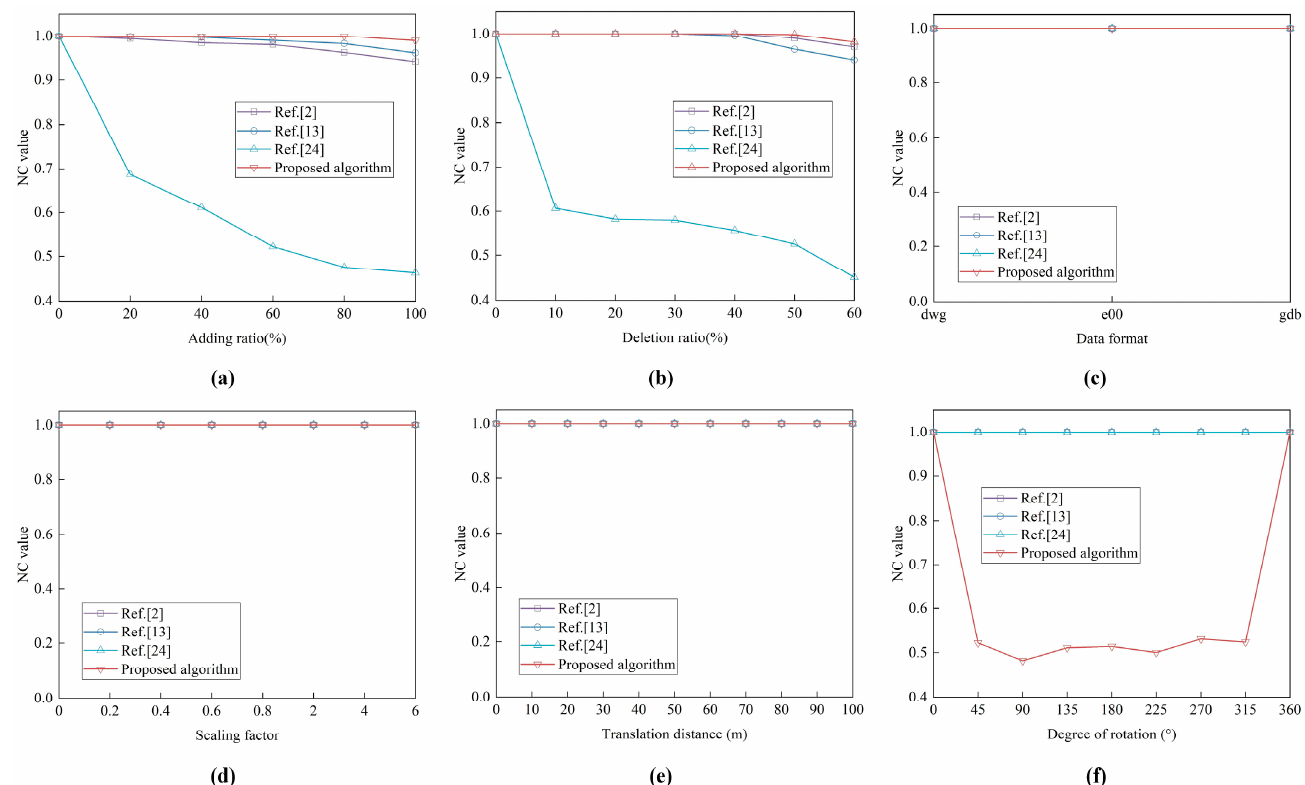
Figure 11. Comparison results for vertex attacks: ( a ) comparison results for vertex addition, ( b ) comparison results for vertex deletion, ( c ) comparison results for data format conversion attack, ( d ) comparison results for scaling attack, ( e ) comparison results for translation attack, ( f ) comparison results for rotation attack.